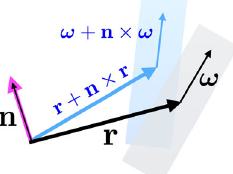
Fig. 6 Illustration of the rotation operation of uniaxial particles. The particles (rectangular shapes) at position r and with orientation ω are shown in original (black) and rotated (blue) con fi guration, where n indicates the rotation axis (direction) and angle